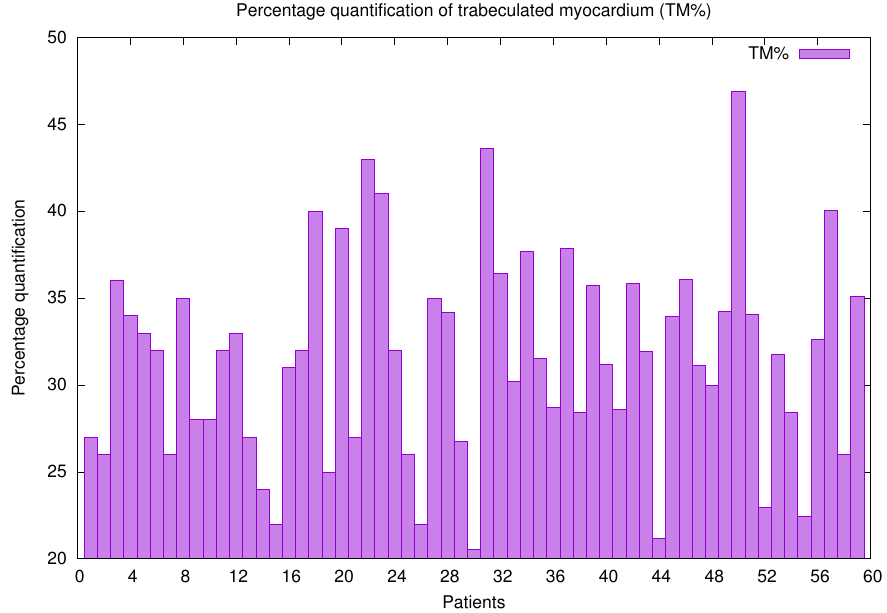
Figure 3. Percentage quantification of trabeculated myocardium (TM%) computed by QLVTHCI for patients (X1–X59).